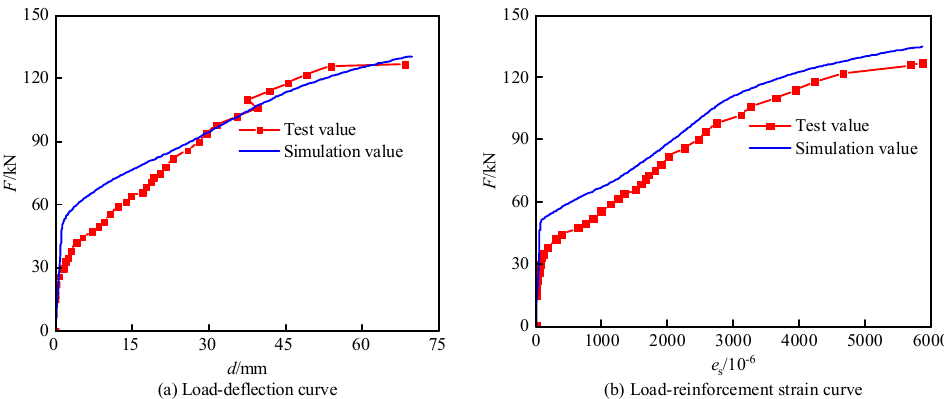
Figure 19. Load-deflection curve and load-reinforcement strain curve.